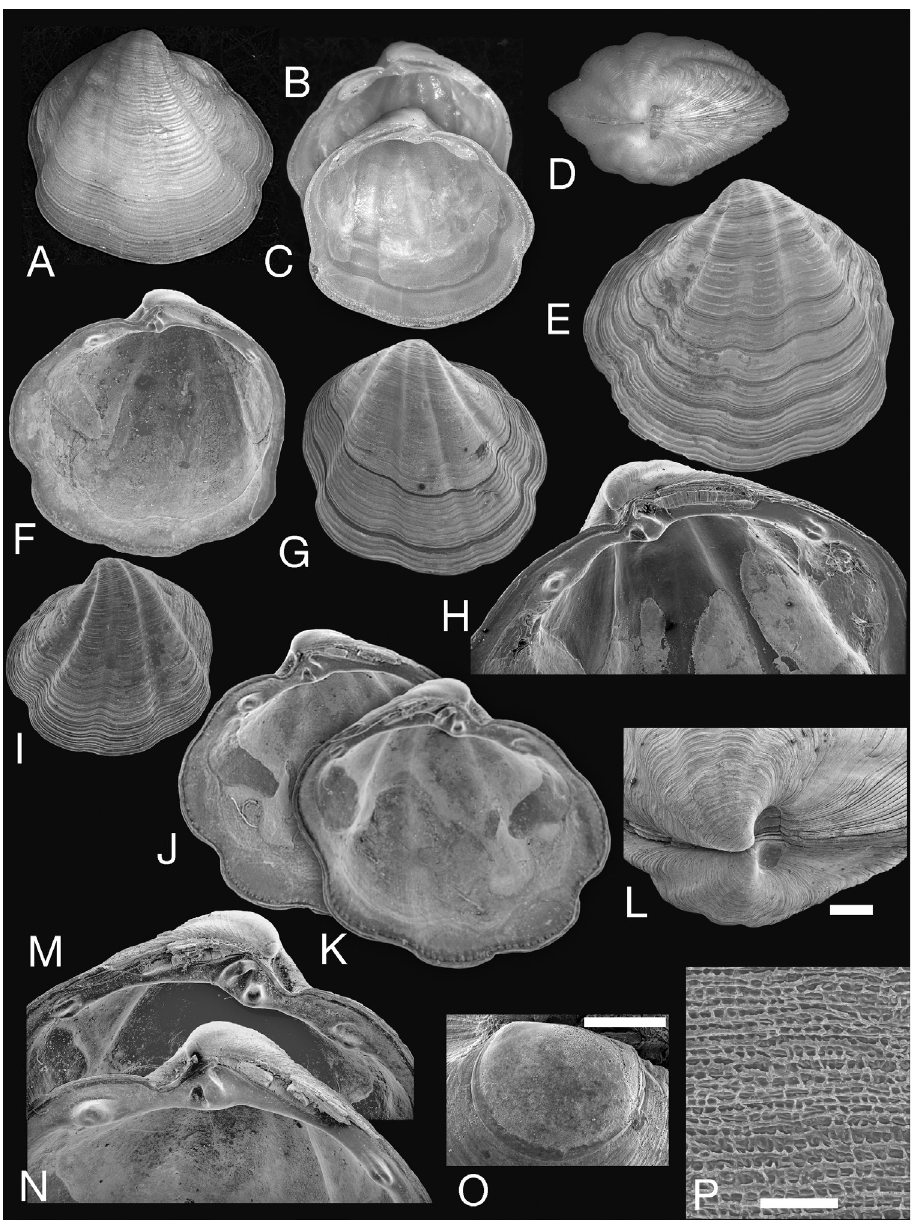
Figure 1. Pleurolucina harperae sp. n. A–C Holotype NHMUK 20160338 exterior of right and interior of right and left valves L 8.8 mm. D–P Paratypes. NHMUK 20160339 dorsal view L 7.6 mm. E Exterior of left valve L 7.7 mm. F Interior of right valve L 6.3 mm. G Exterior of right valve L 7.9 mm. H Hinge area of right valve L 8.6 mm. I Exterior of left valve L 63 mm. J , K Interiors of right and left valves L 5.0 mm. L Dorsal view showing lunule. Scale bar = 0.5 mm. M , N Details of hinge teeth of J, K. O Proto- conch. Scale bar = 100 µm. P Detail of microsculpture. Scale bar = 20